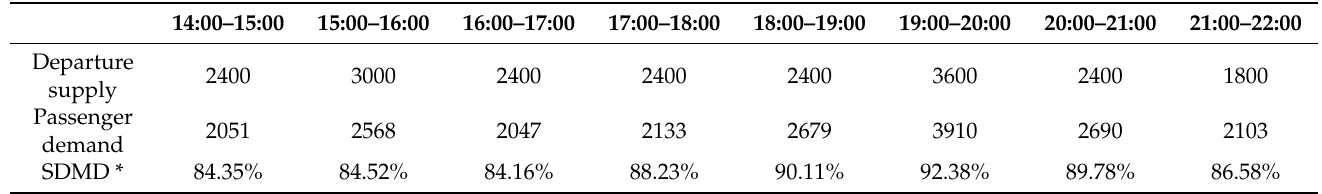
Table 18. Details of supply and demand matching degree of multi-cycle timetable of intercity railway